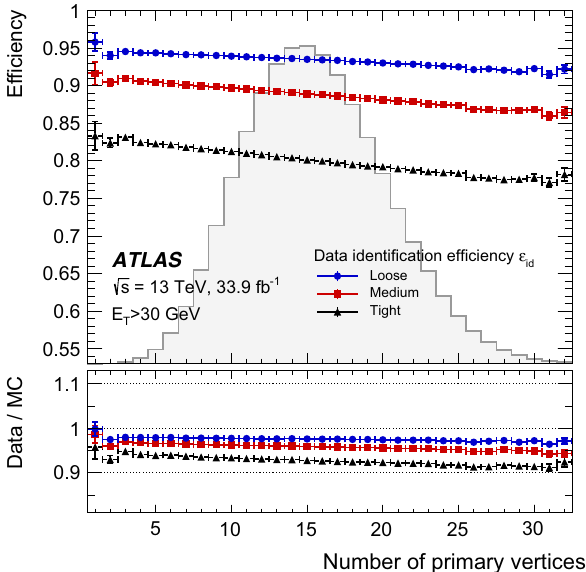
Fig. 9 The LH electron-identification efficiencies for electron candi- dates with E T > 30GeV for the Loose (blue circle), Medium (red square), and Tight (black triangle) operating points as a function of the number of primary vertices in the 2016 data using the Z → ee process. The shaded histogram shows the distribution of the number of primary vertices for the 2016 data. The inner uncertainties are statistical while the total uncertainties include both the statistical and systematic components. The bottom panel shows the data-to-simulation